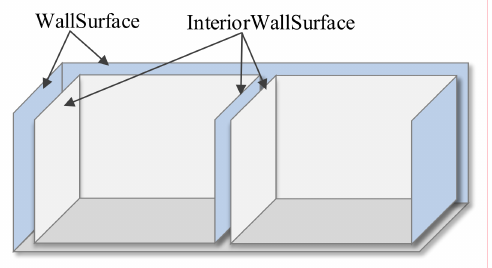
Figure 7. Representation of walls in CityGML.